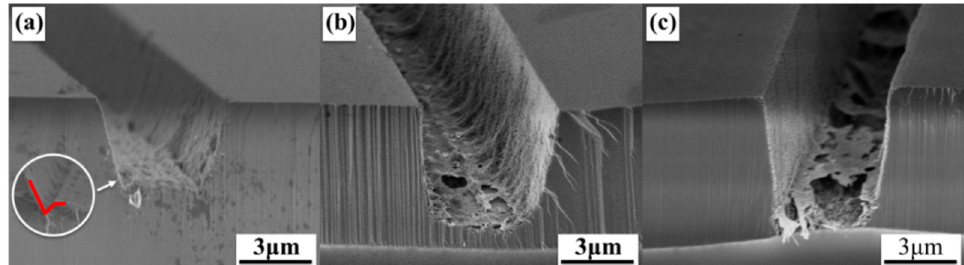
Figure 4. Cross-sectional SEM images (45°-tilt view) of the etched GaN stripe structures with different etching times: ( a ) 20 min, ( b ) 40 min, and ( c ) 60 min.